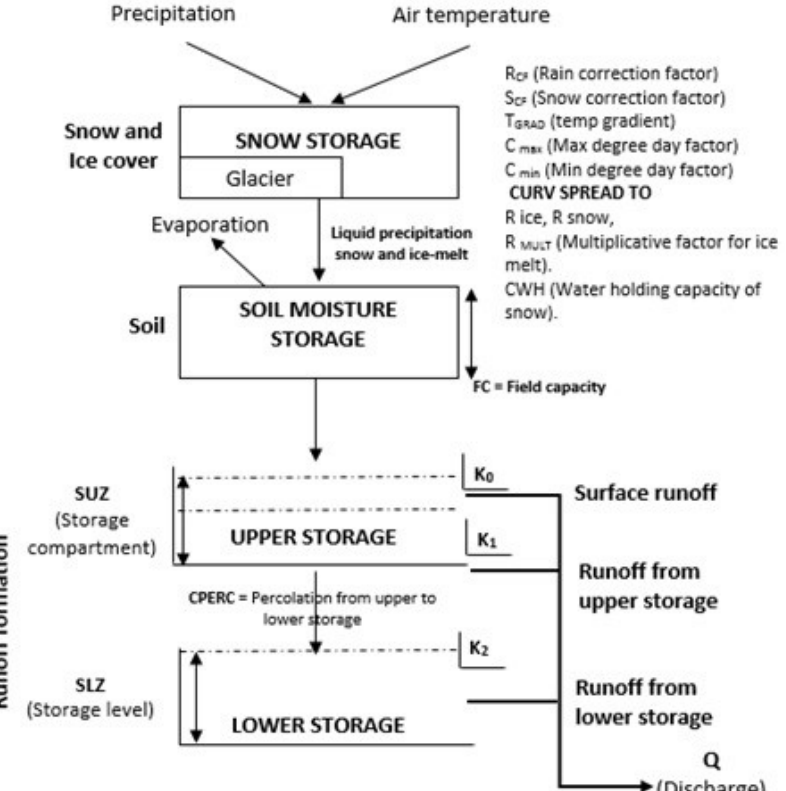
Figure 5. Schematic structure of HBV-ETH model (after [17]). Input data include daily temperature and precipitation as well as catchment topography and glacier cover statistics. The model has snow and glacier modules and uses seasonally-varying degree day factors. The upper panel shows the main model parameters.